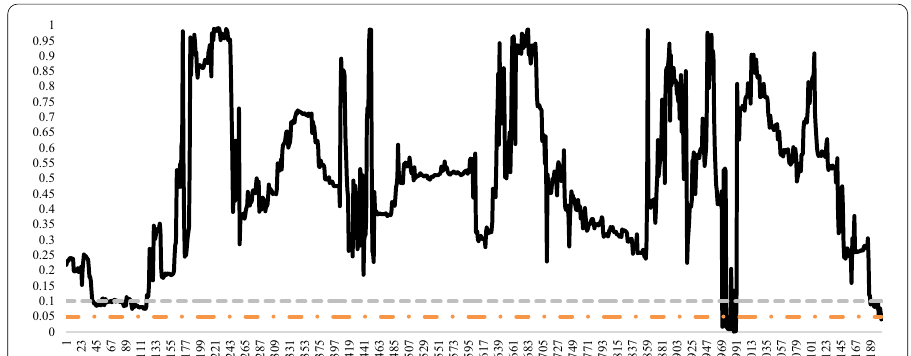
Fig. 13 The evolving p values of the AQ test statistic checked for the Ripple (XRP) in 150-day window length